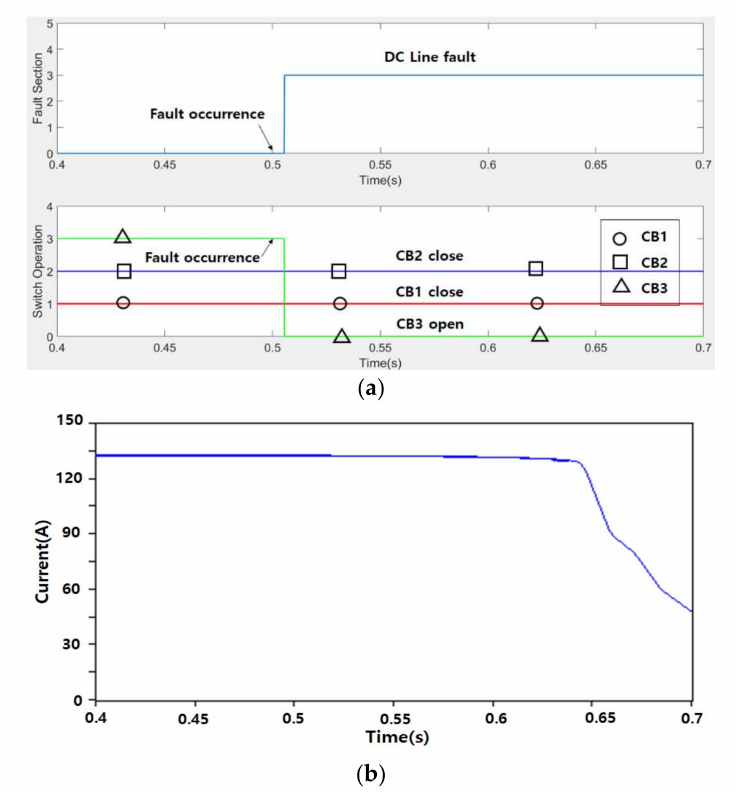
Figure 25. Simulation results of Case 11: ( a ) Fault section and CB operation and ( b ) Load